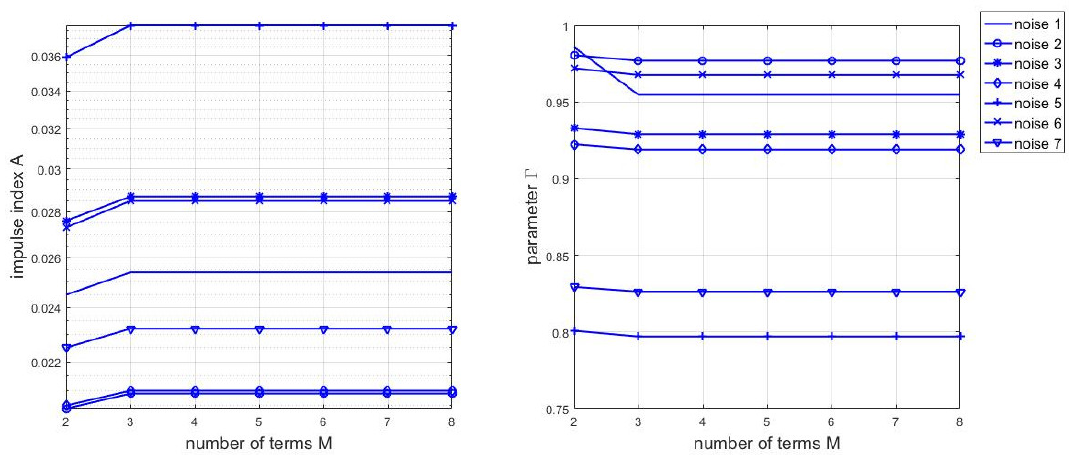
Figure 10. A and Γ versus the number of terms M for noise measured in Italy.